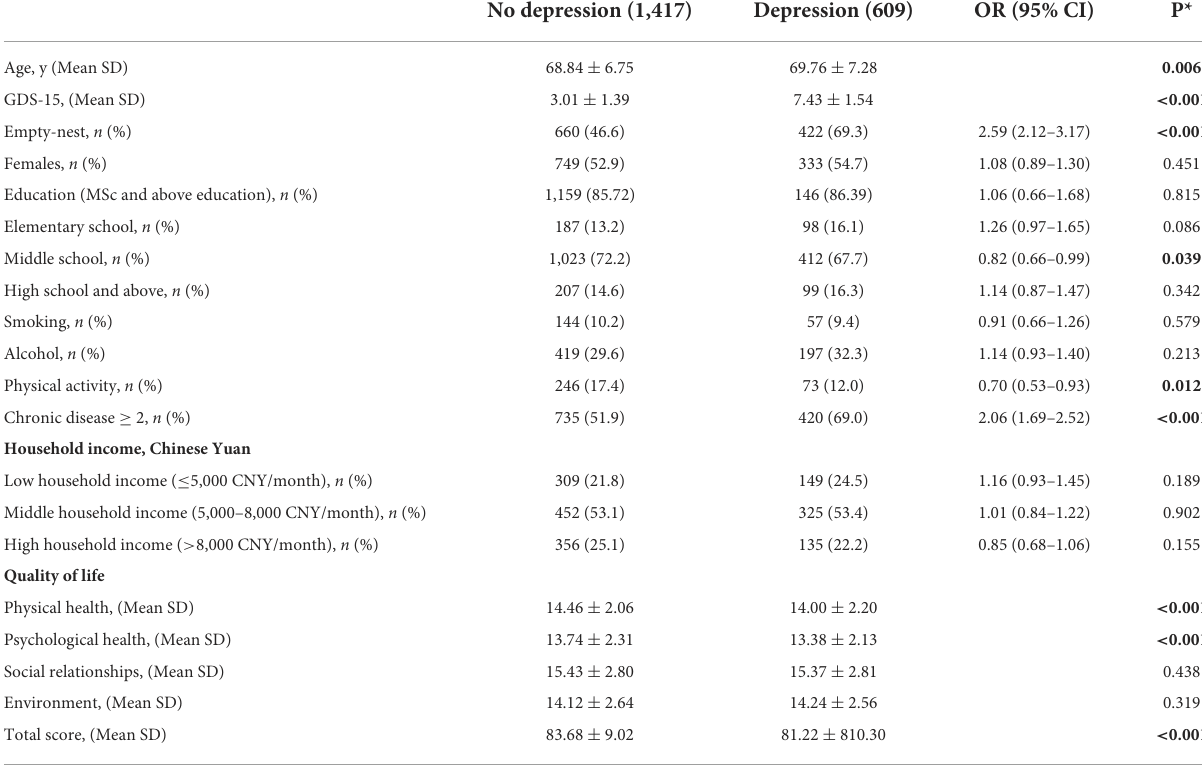
TABLE 2 Comparison of baseline characteristics between no depression and depression symptoms